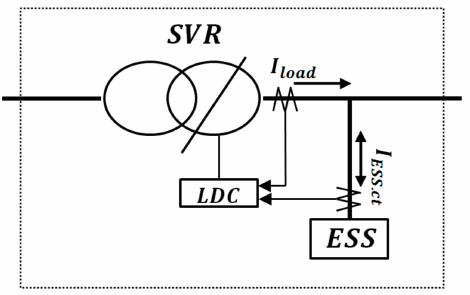
Figure 9. Concept for the proposed current measuring method of SVR and ESS.